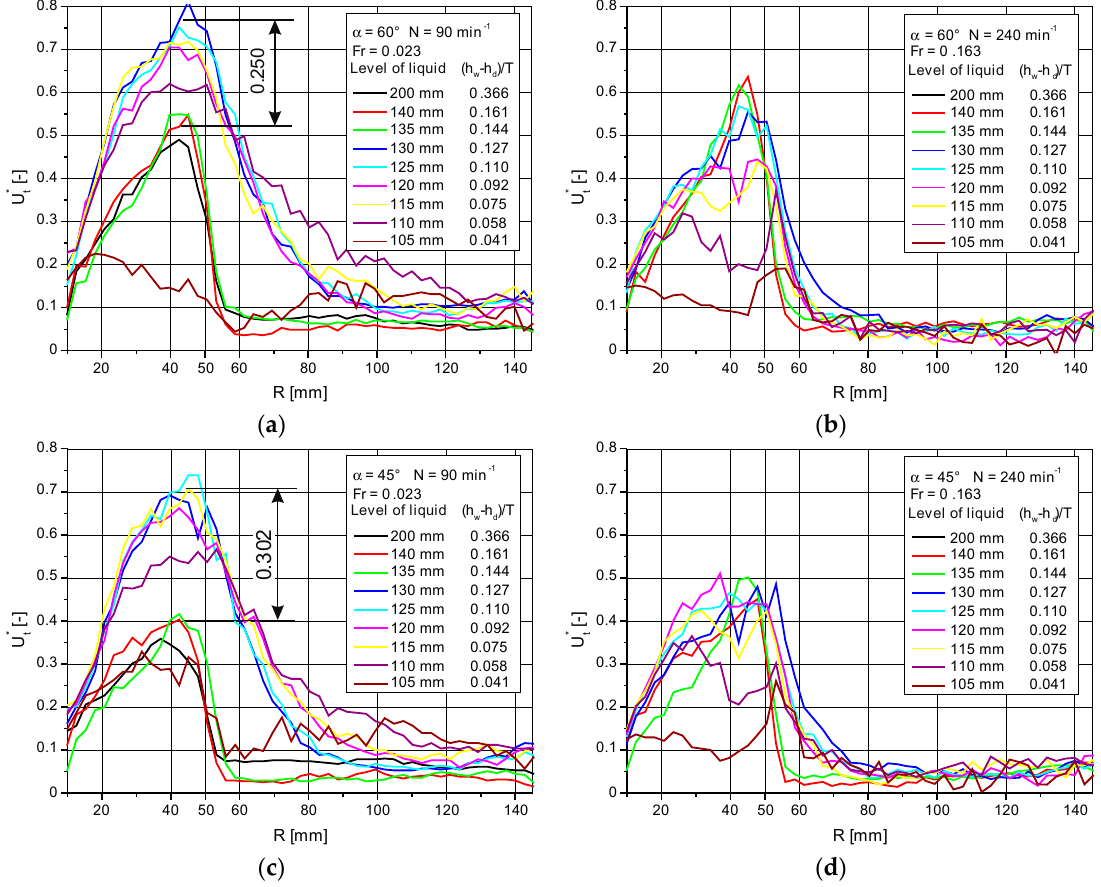
Figure 6. Tangential velocity profiles at the height of the impeller h m . ( a ) N = 90 min − 1 , α = 60°; ( b ) N = 240 min − 1 , α = 60°; ( c ) N = 90 min − 1 , α = 45°; ( d ) N = 240 min − 1 , α =45°.